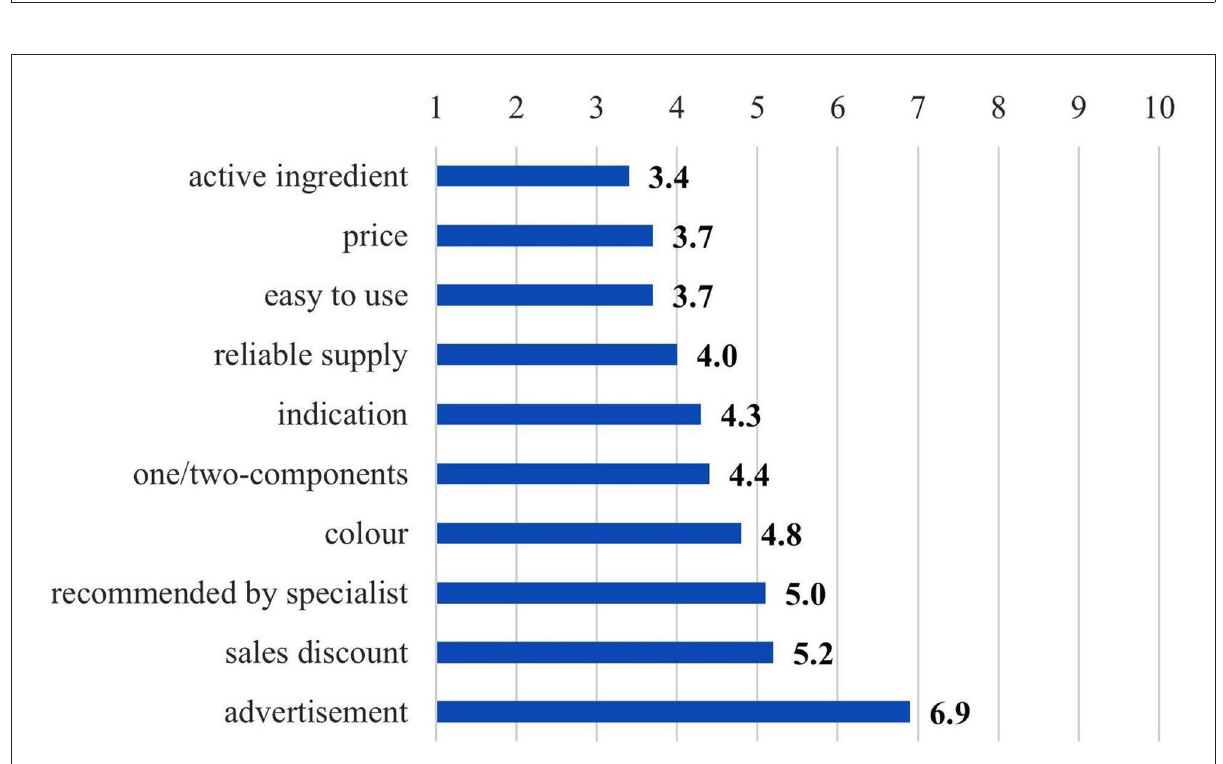
FIGURE3 Importance of different procurement factors for pre- and post-milking disinfectants ( n =